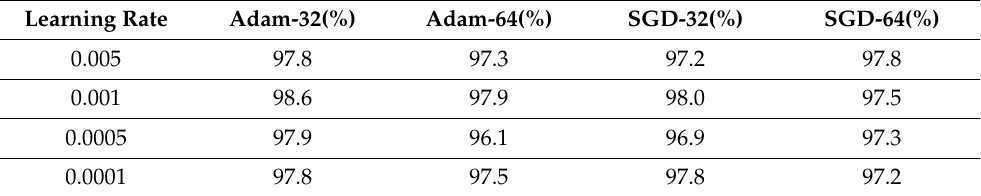
Table 3. Comparison of